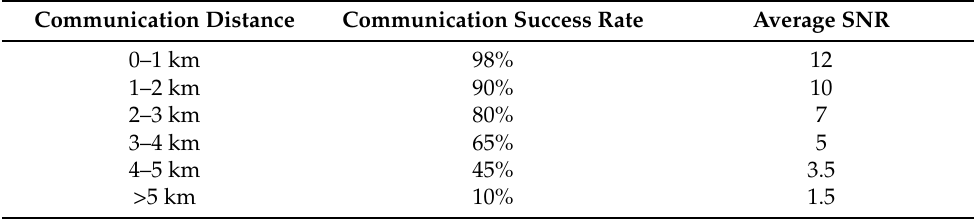
Figure 5. Point-to-Point communication tests in a real field environment. Table 1. P2P communication test results in underwater